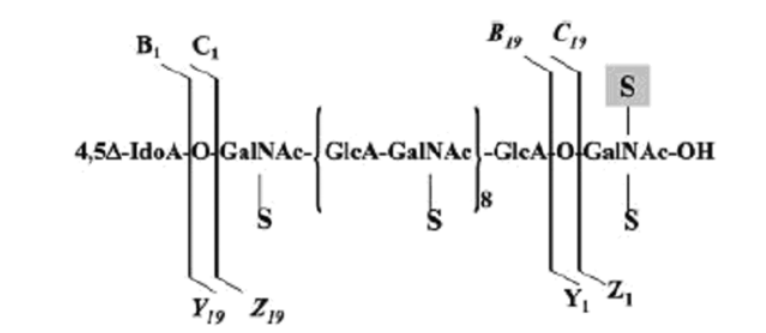
FIGURE 4. Structural proposal for the oversulfated unsaturated eicosasaccharide 4,5- Δ - IdoAGalNAc[GlcAGalNAc] 9 (11S) identified in galactosaminoglycans mixture derived from recombinant expressed decorin according to the data obtained by on-line CE/ESI-autoMS/MS. Reprinted with permission from